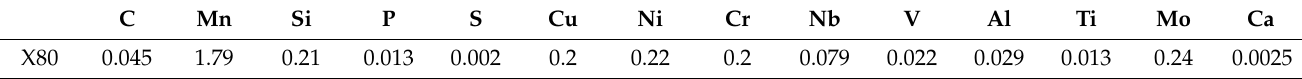
Table 1. Chemical composition of X80.